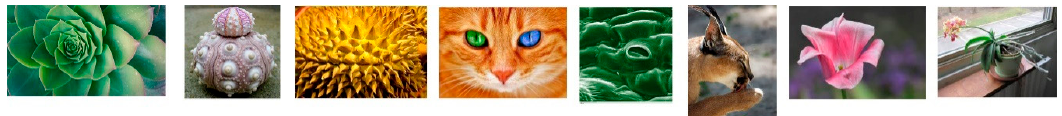
Figure 11. Examples of adaptations or characteristics from left to right; in morphology—succulent’s form, sea urchin’s structure, durian’s thorns; in physiology—eye color trait, photosynthesis of stoma; in behavior—licking paws for evapotranspiration, thermonasty, and phototropism.